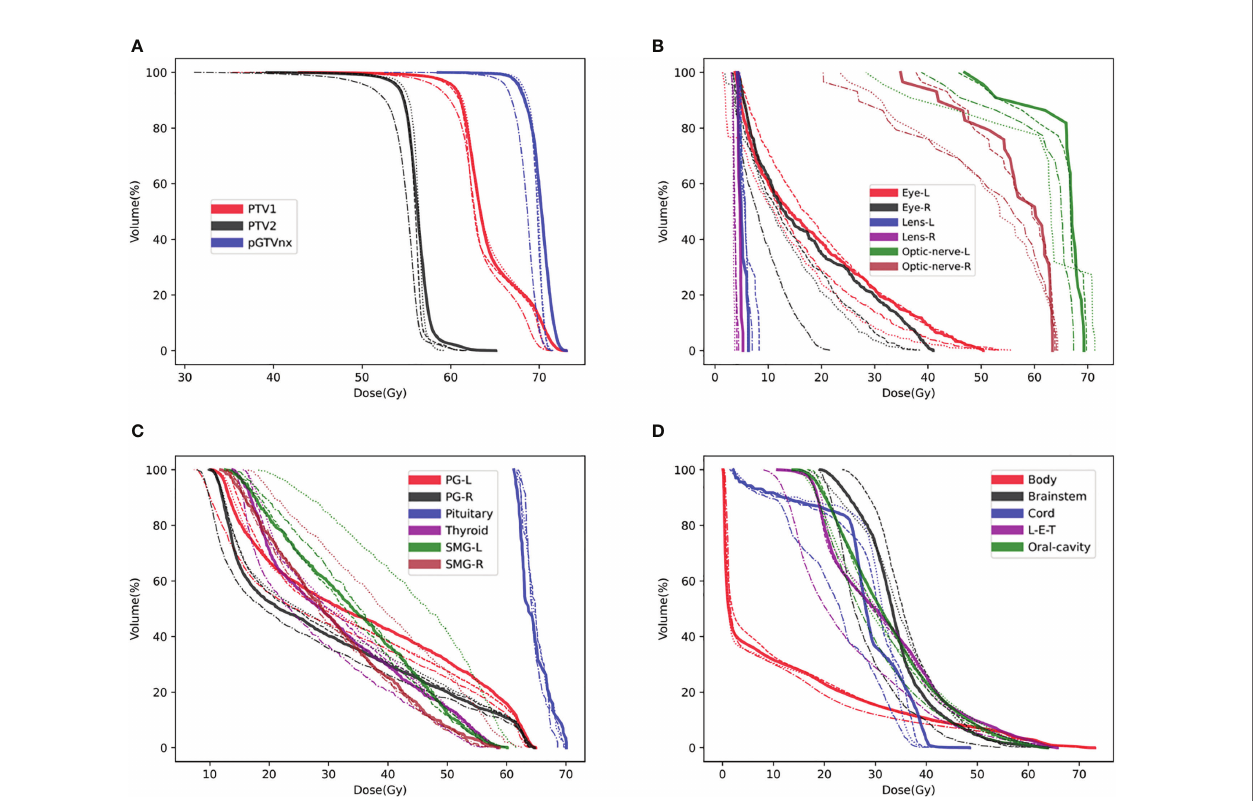
FIGURE 3 | DVH plots for a test patient, such as (A) DVH plot of PTVs, (B) DVH plot of optic organs, (C, D) DVH plots of the other OARs. DVH, Ground-truth (Solid line), Model I (Dashed line), Model II (Dashed and dotted line), Model III (Dotted line).